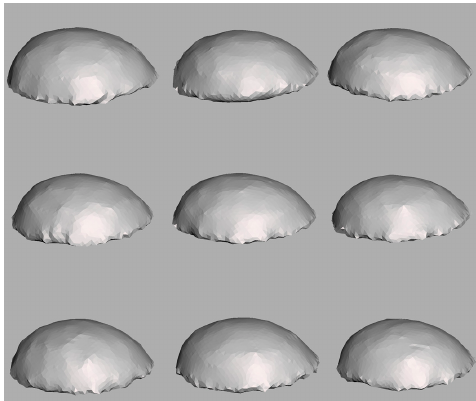
Figure 6. Humeral head shape variation synthesized by the statistical shape model (SSM), where the horizontal direction corresponds to the first principle component (PC) score and vertical direction corresponds to the second PC score.